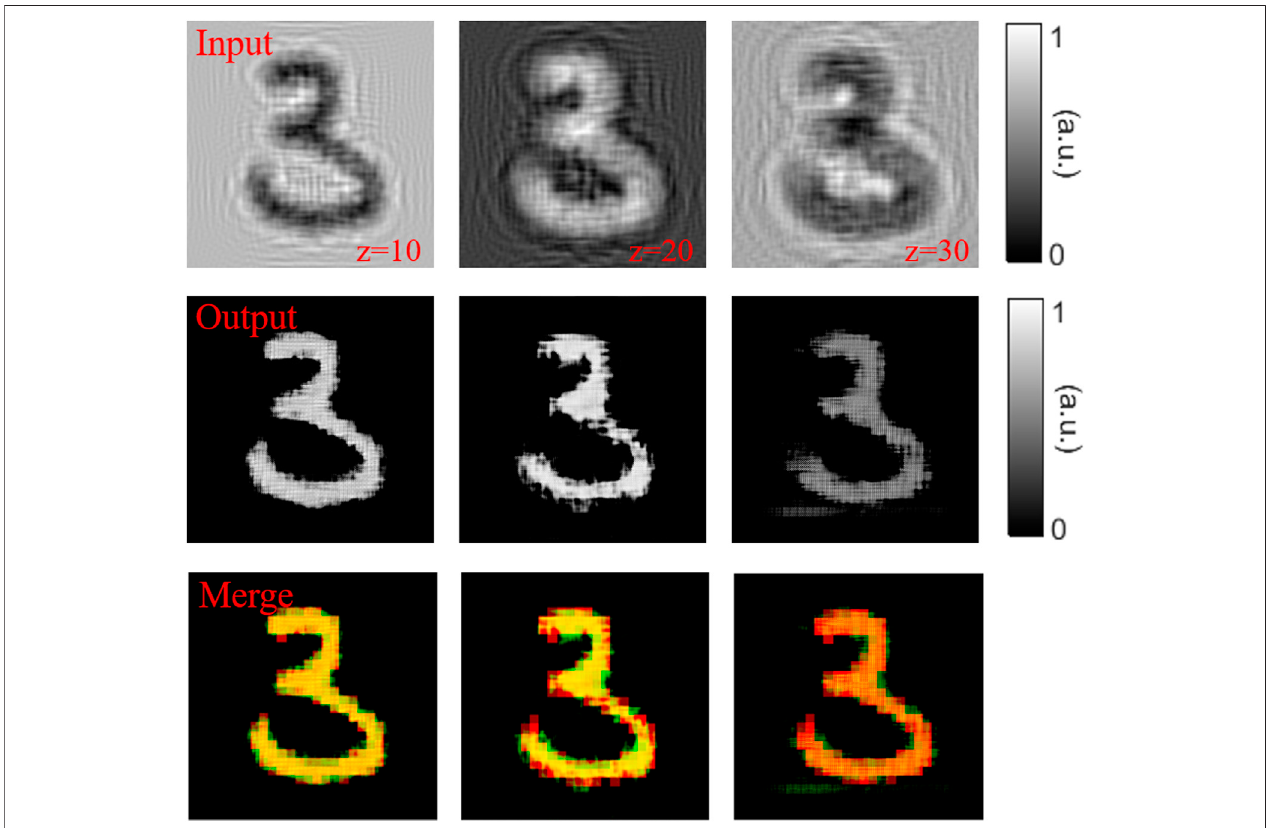
FIGURE 5 | Acoustic hologram reconstruction results of digit 3 at different holographic recording distances (z = 10, 20, and 30 mm) are used to evaluate the robustness ofPhysNet-AH.The fi rst row shows thediffractedacoustic fi eld intensity from the holograms ofdigit3at z = 10,20, and 30 mm. The second row shows the corresponding reconstruction results from the abovementioned acoustics fi elds. The last row shows the merged images of the target digits (ground truth) and the reconstructed images. Red represents the ground truth, green represents the reconstructed results of PhysNet-AH, and yellow represents their overlaps.